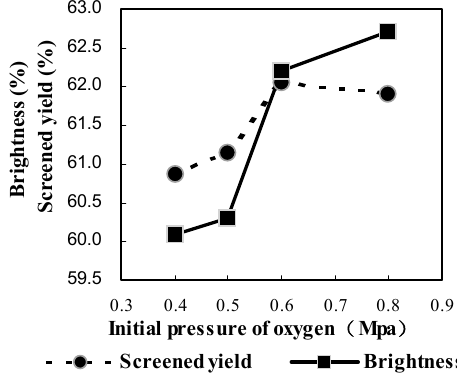
Figure 1. Influence of initial pressure of oxygen on screened yield and brightness.